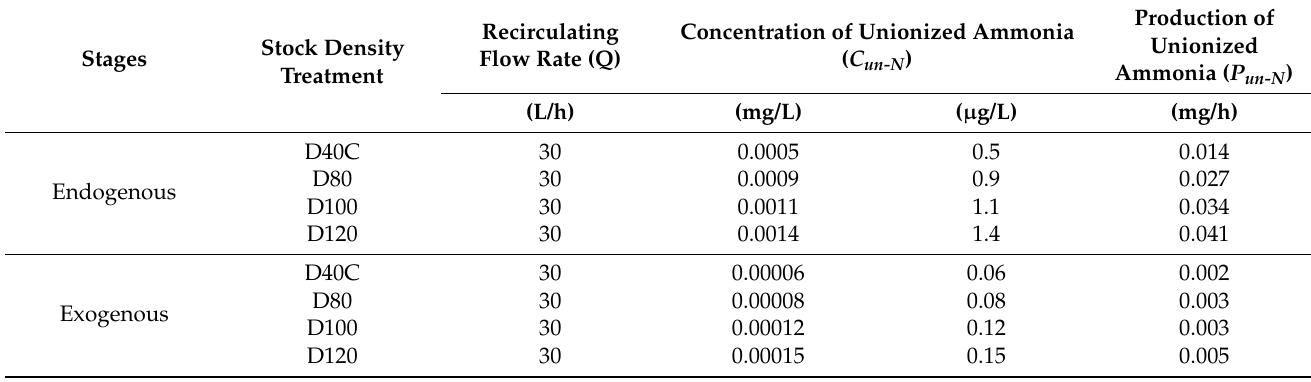
Table 5. Unionized ammonia production (NH 3 -N) in each striped catfish ( Pangasianodon hypophthal- mus ) larva media at various stock densities in UFBs-RAS.